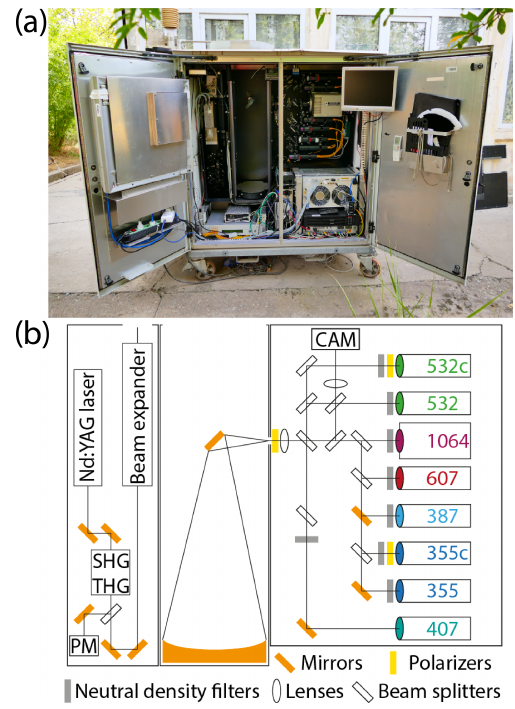
Figure 2. (a) Polly XT with closed roof, open doors, and removed protective plates at the Poligon field site in Dushanbe. The cabinet size is approximately 1.9m × 1.7m × 0.9m. (b) Schematic of the optical layout of the Polly XT . Left (transmitter part): after the sec- ond harmonic generation (SHG) and the third harmonic generation (THG), parts of the laser beam are deflected to a power meter (PM) which measures the UV component to monitor the conversion ef- ficiency. Right (receiver part): backscattered light is collected with a Newtonian telescope and then passed towards the receiver unit. The numbers indicate the wavelength in nanometers of the detec- tion channels and c denotes the cross-polarized channels. A camera (CAM) is synchronized to the laser trigger and sees the beam at 532nm wavelength to monitor the overlap. The polarizer mounted in front of the pinhole is a device for the absolute calibration of the depolarization measurements (for details see Engelmann et al., 2016).